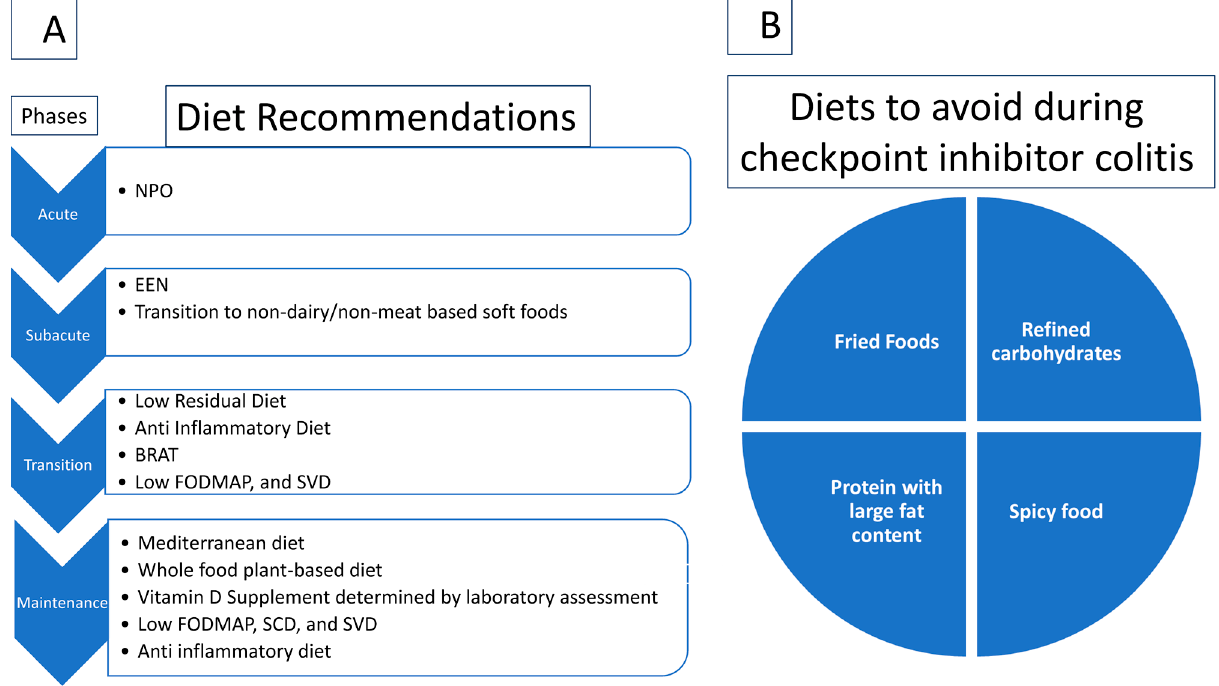
Figure 1. ( A ) Diet recommendations per stage. Abbreviations: BRAT, banana, rice, applesauce, and toast; EEN, exclusive enteral nutrition; Low FODMAP, low fermentable oligosaccharides, disaccha- rides, monosaccharides, and polyols; NPO, nothing by mouth; SCD, specific carbohydrate diet; SVD, semi-vegetarian diet. A diet is typically introduced after acute colitis symptoms have subsided with high-dose steroids during the transition period. ( B ) Diets to avoid during checkpoint inhibitor colitis toxicity. Large meals should be avoided. In addition, fried foods, refined carbohydrates, proteins with large fat contents, and spices (red hot peppers, chili peppers, etc.) should also be avoided.